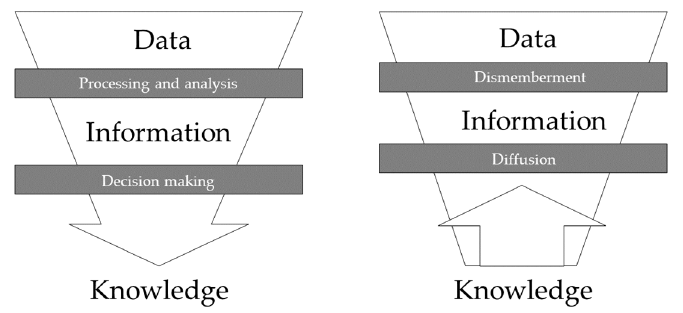
Figure 1. Importance of hierarchy between Data, Information, and Knowledge in MCDM. The people represent one of the most significant resources of an